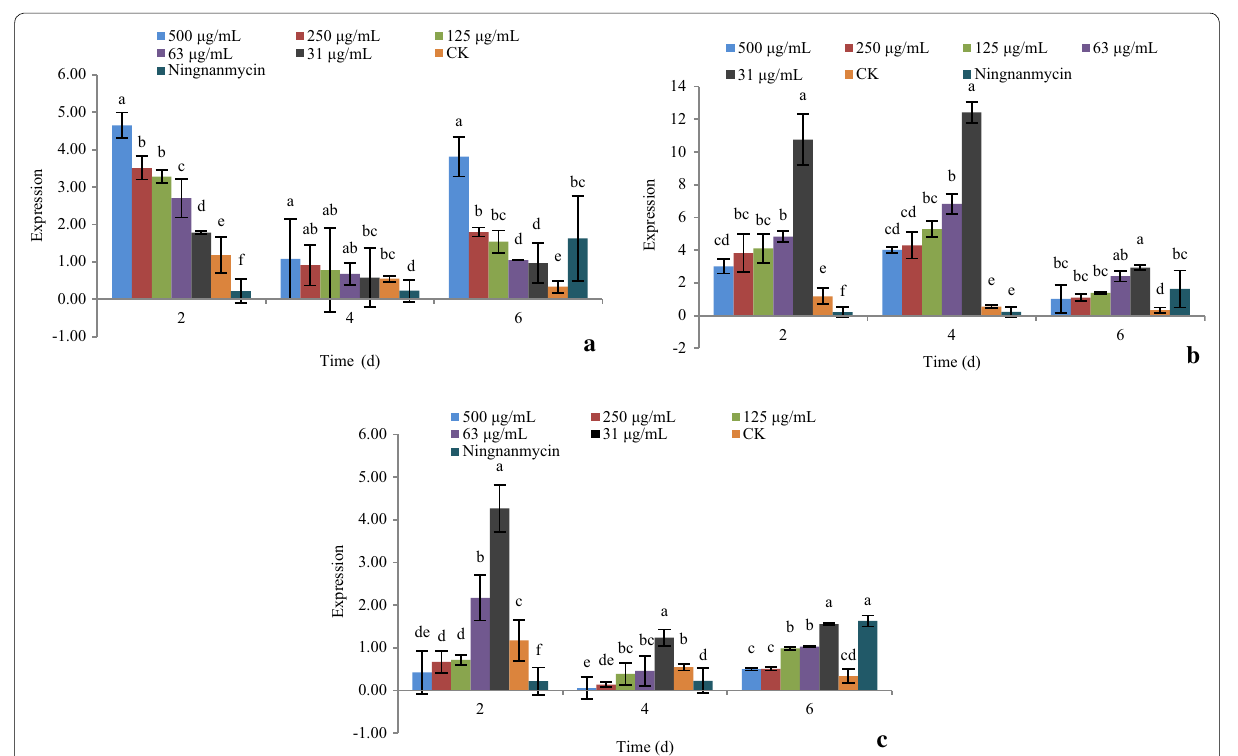
Fig. 4 The effect of active compounds 1 , 5 , and 9 on the expression of gene Lhc . a Compound 1 ; b Compound 5 ; c Compound